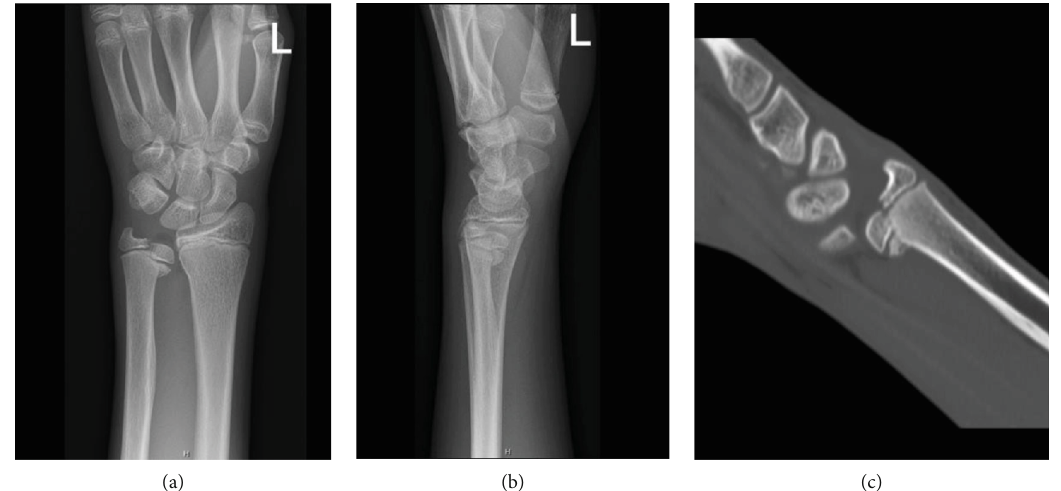
Figure 1: (a, b) Anteroposterior and lateral X-ray after trauma showing an isolated Salter-Harris type IV fracture of the ulna. (c) Sagittal CT image showing an intraarticular step of 3mm.